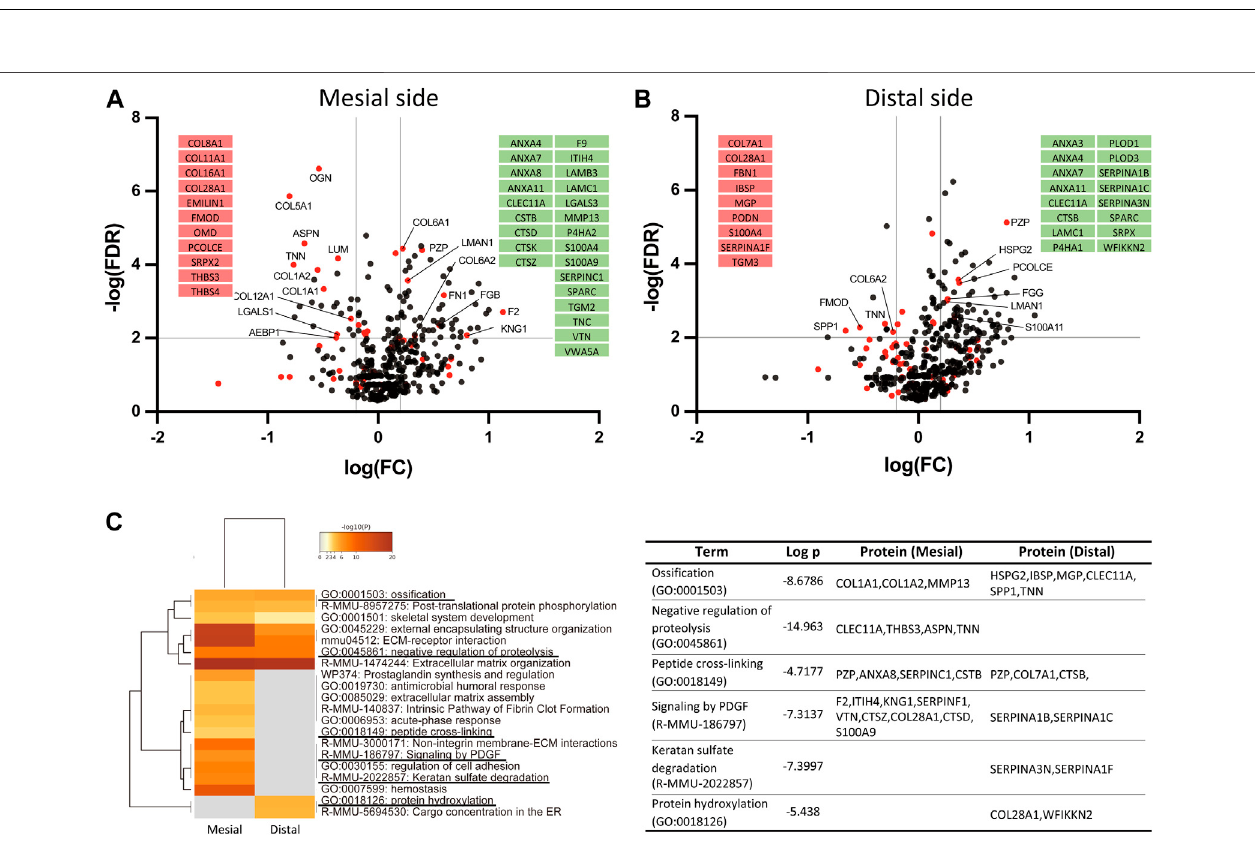
FIGURE5| Identi fi cationofECM-orienteddifferentiallyexpressedproteins(DEPs)andenrichmentanalysis.VolcanoplotoftheDEPsatthemesial (A) anddistal (B) sidesofthePDL.Matrisome proteins areshown inreddotsand otherproteinsareshown inblackdots. Thematrisome proteinsexclusivelydetectedonlyincontrol(red) or at day 14 (green) are shown in insets. (C) Pathway- and process-enrichment analyses of ECM-oriented DEPs in the mesial and distal sides of the PDL.